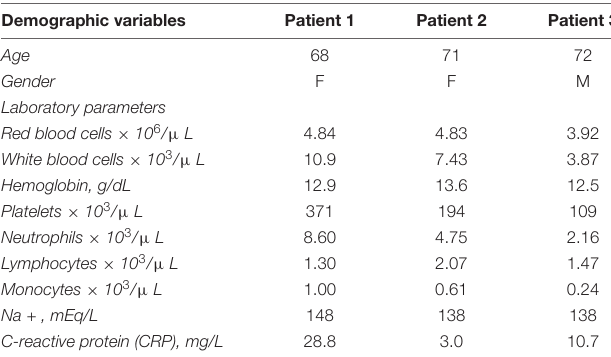
TABLE 2 | Demographic characteristics and laboratory parameters at admission of the three patients included in the study. Demographic